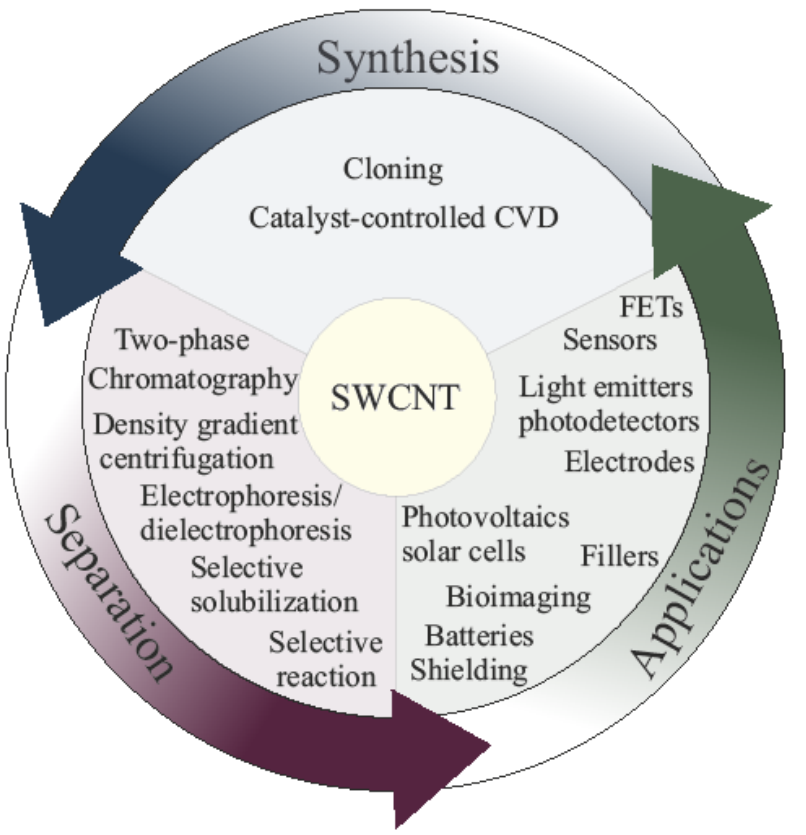
Figure 1. The main synthesis routes, separation methods, and applications of single-chirality SWCNT.